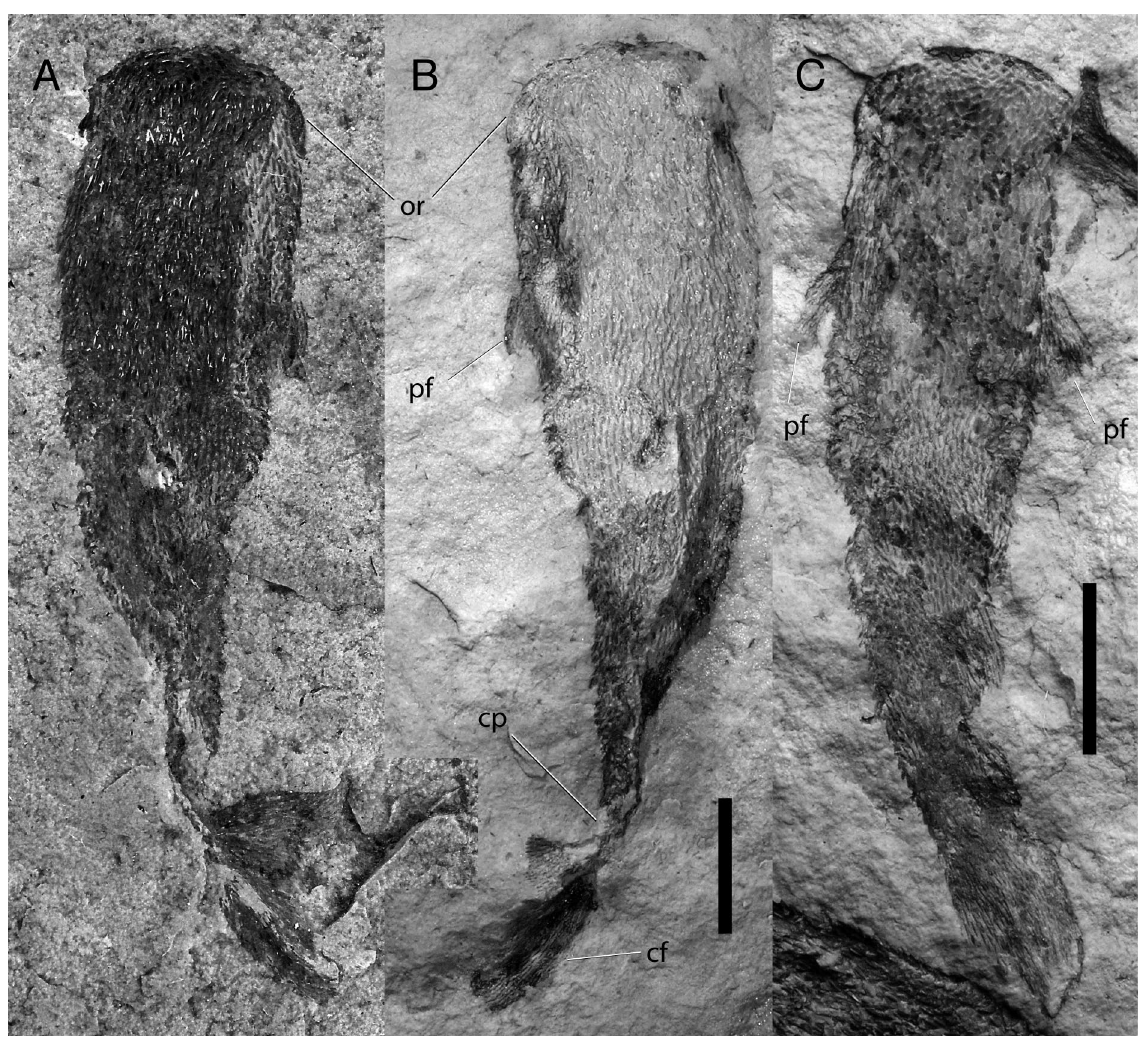
Fig. 3. Phlebolepis elegans Pander. Specimens preserved in dorsal view, from Himmiste-Kuigu, Saaremaa, Estonia. A , TUG 865-14-1, counterpart of B; B , TUG 865-14-6, counterpart of A; C , TUG 865-14-2. Scale bars are each 1 cm. Abbreviations: cf, caudal fin; cp, caudal peduncle; or, orbital scales; pf, pectoral